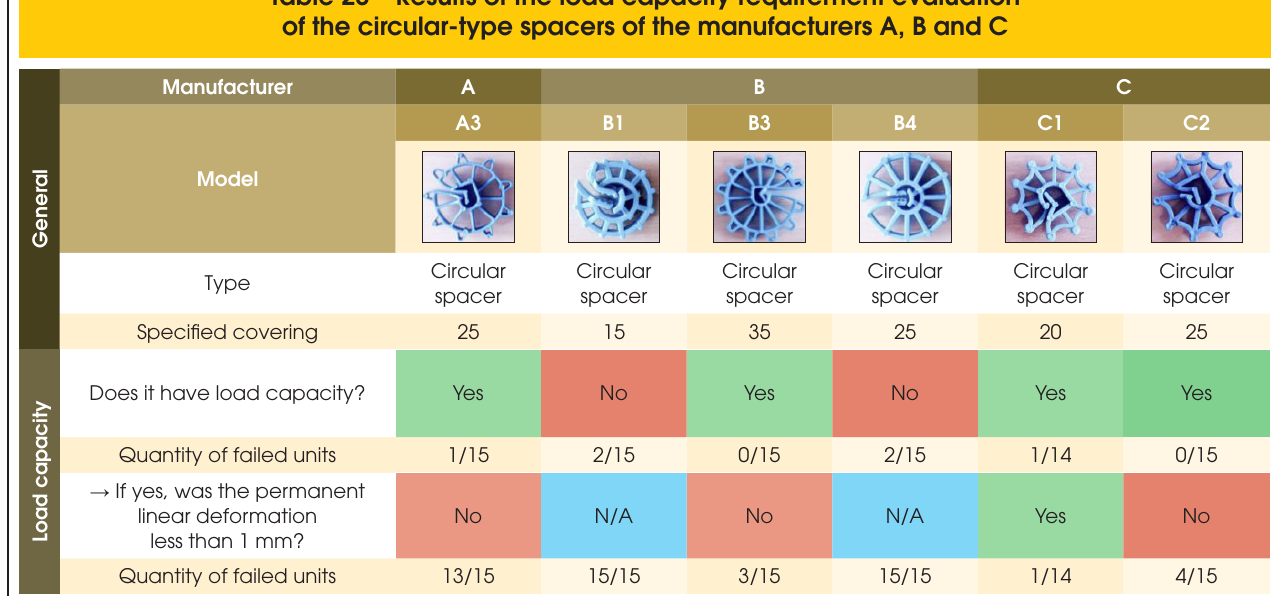
Table 20 – Results of the load capacity requirement